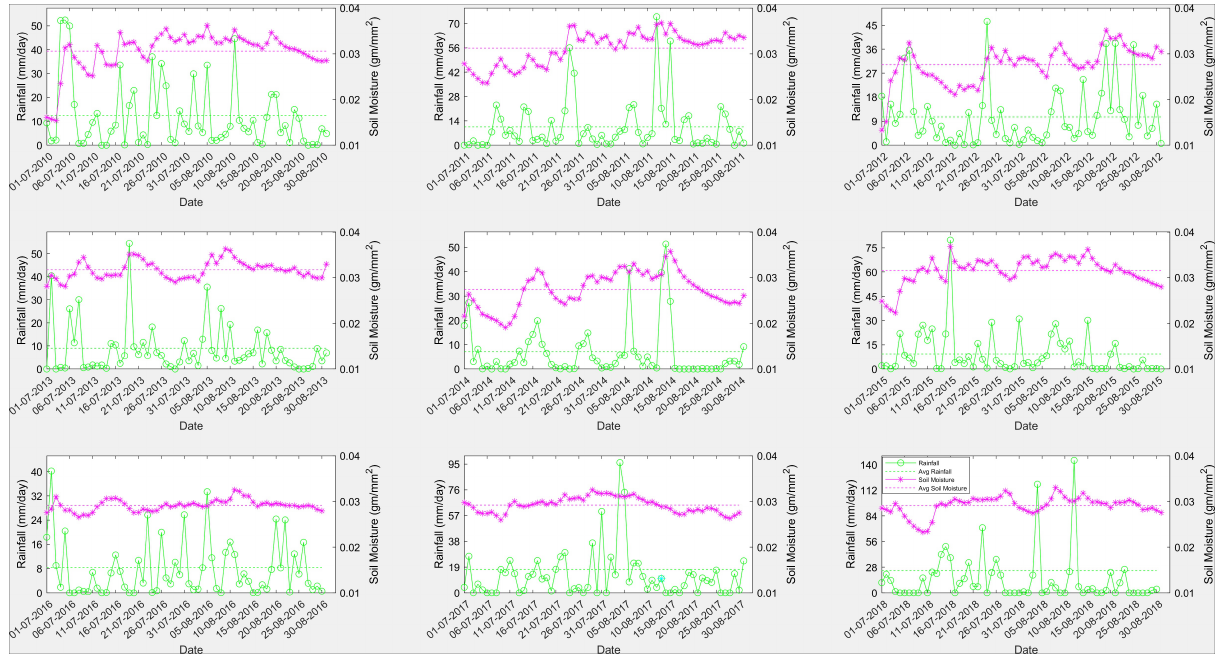
Figure 6. Soil moisture (cm) profile for July- August Months at depth of 0-10 cm with rainfall intensity for 2010, 2011, 2012, 2013, 2014, 2015, 2016, 2017, 2018 and 2019 slow infiltration/percolation o f w ater i nto t he soil/rock through cracks and may have likely to increase pore water pressure leading to decrease in strength of the slope. As predicted through various models, the rainfall shows increasing trend in the future, hence the increasing rainfall could be an alarming scenario as it can directly lead to slope instability and landslide